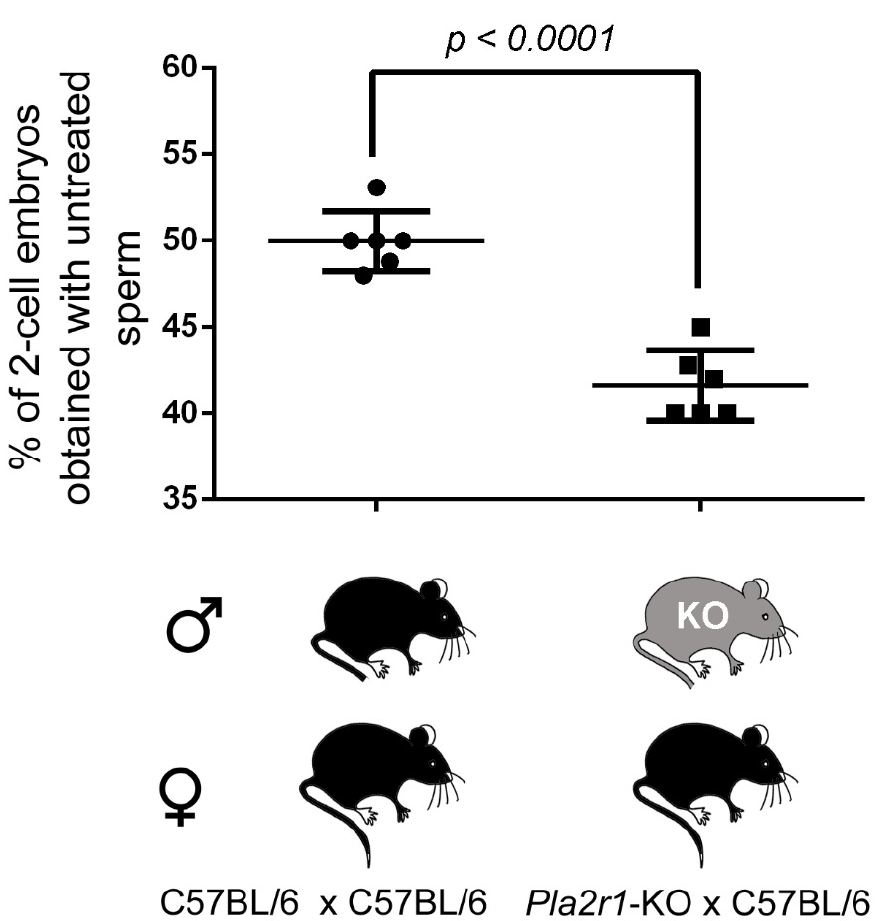
Figure 8. IVF outcome is decreased when sperm were obtained from Pla2r1 -KO males. Comparison of the % of two-cell embryos generated by IVF, using oocytes from C57BL/6 and sperm from either WT or Pla2r1 -KO littermate males ( n = 6 for KO and WT males). n represents the number of biological replicates, and the statistical difference was assessed using the t -test and p -value, as indicated. 2.6. H48Q-PLA2G10-Induced Improvement of Fertilization Is Altered with Gametes from Pla2r1